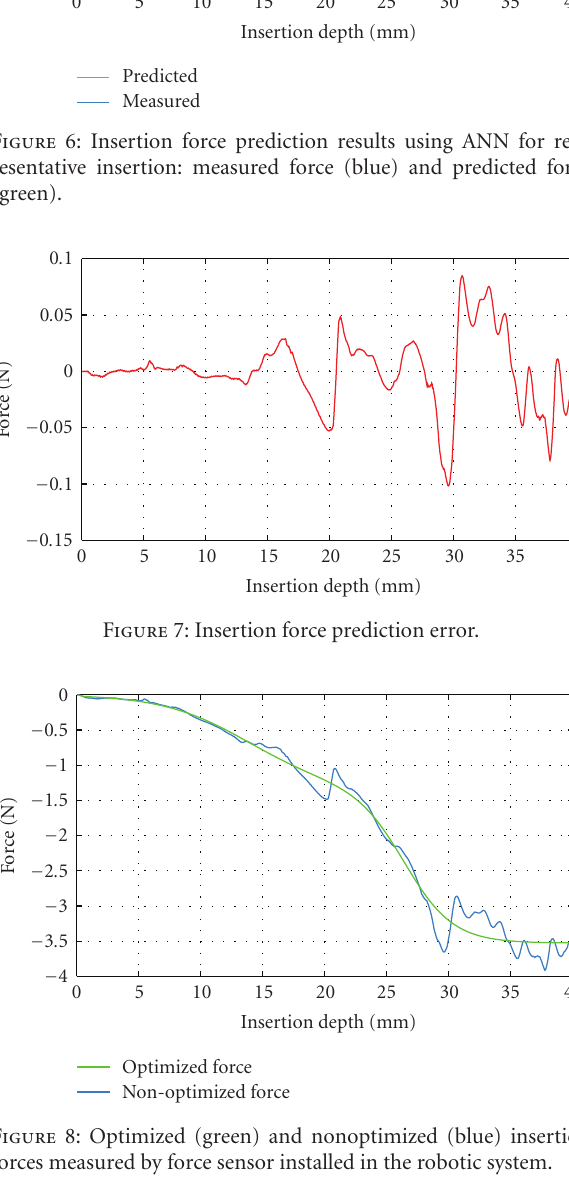
avoided using appropriate initial conditions, defined by x 0 s = Px 0 and x 0 f = Qx 0 . By using the described approach the fast subsystem will not induce impulsive behavior. Moreover,